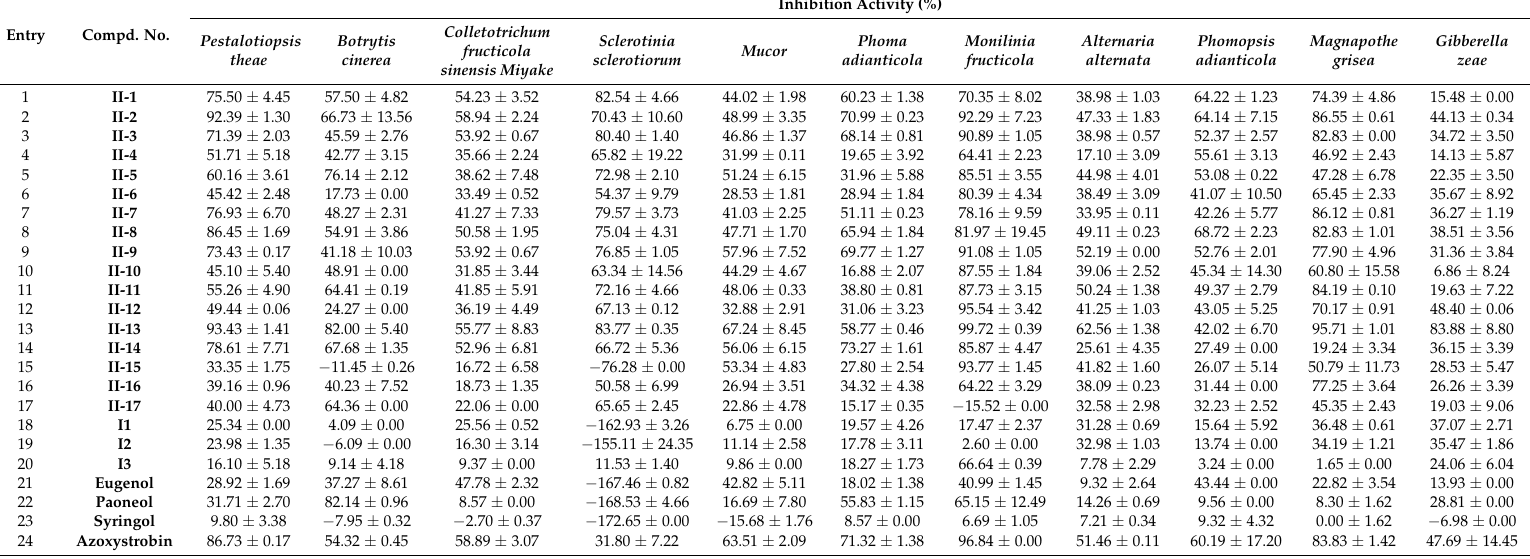
Table 2. The fungicidal activity of EOs-oriented β -methoxyacrylates derivatives II-1 ~ II-17 at a concentration of 100